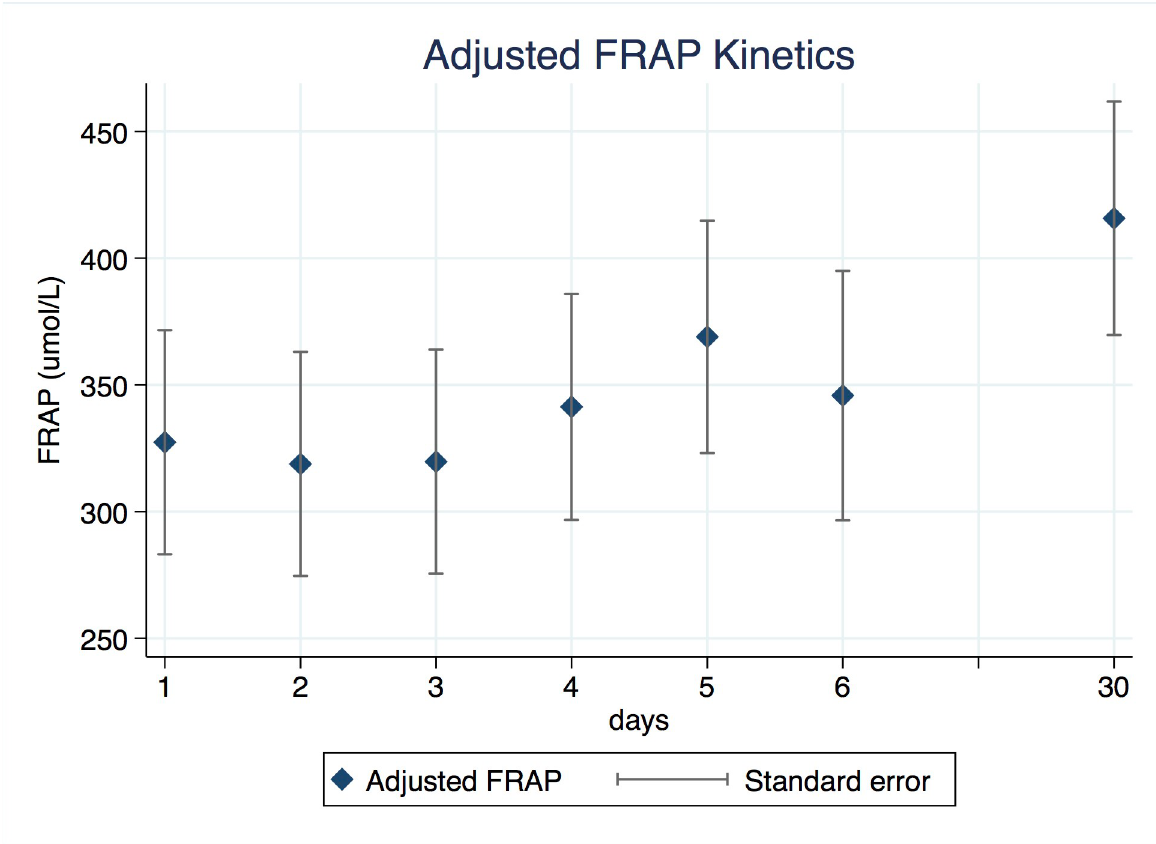
Fig 2. Adjusted FRAP kinetics. Adjusted values of FRAP during the first week after symptoms onset and 30 days later. Diamonds represent uric acid adjusted by sex, age and DWI volume at diagnosis, and data dispersion is presented as standard error.